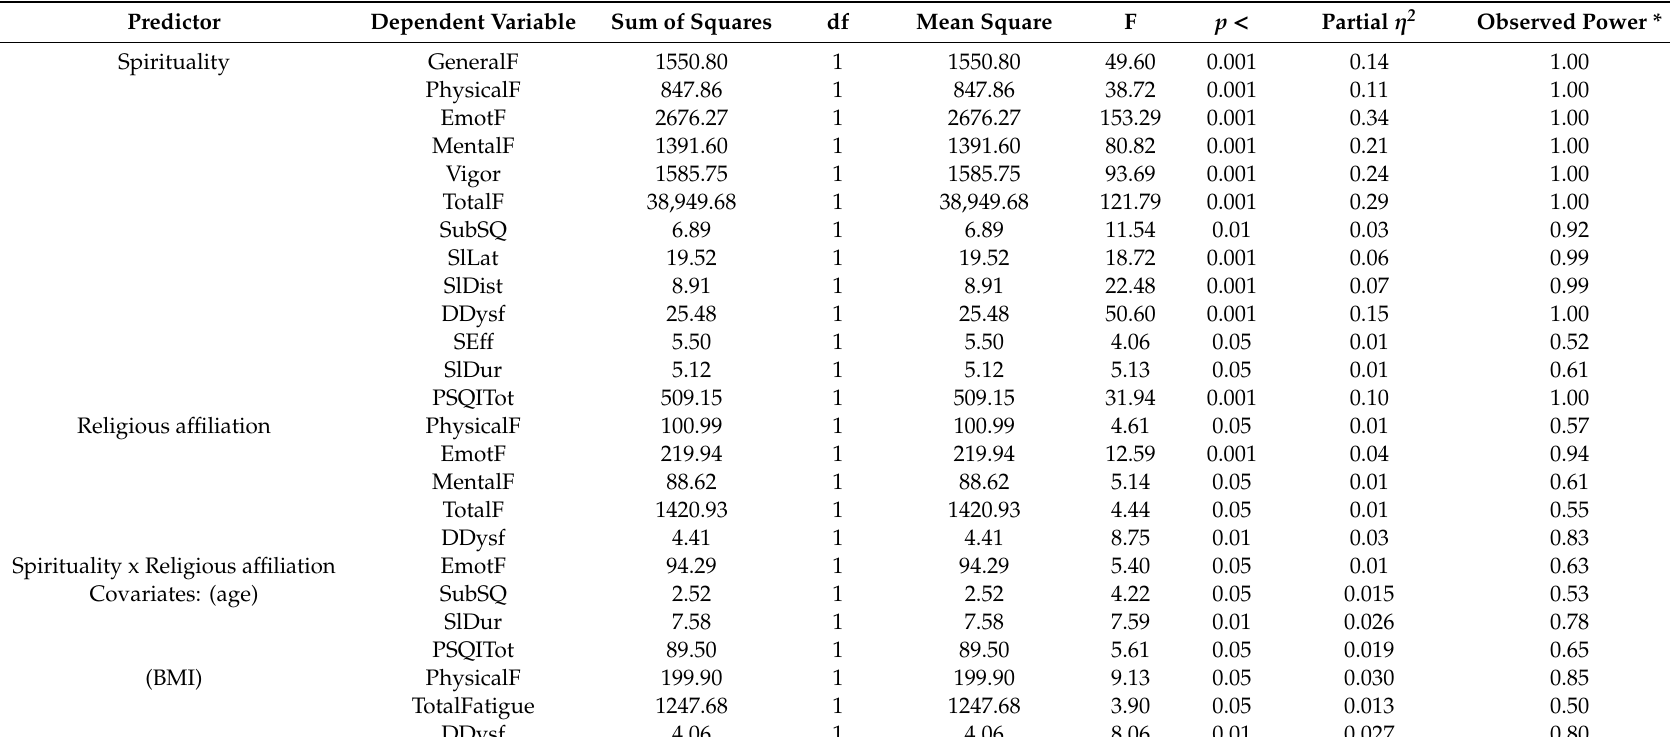
Table 5. The e ff ect of spirituality and religious a ffi liation on physical health